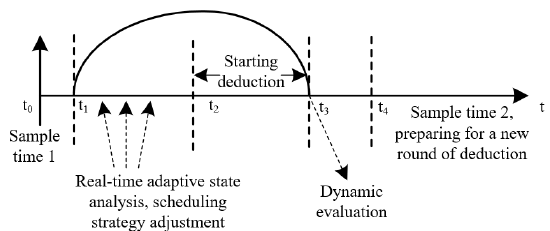
Figure 4. The scheduling strategy method.